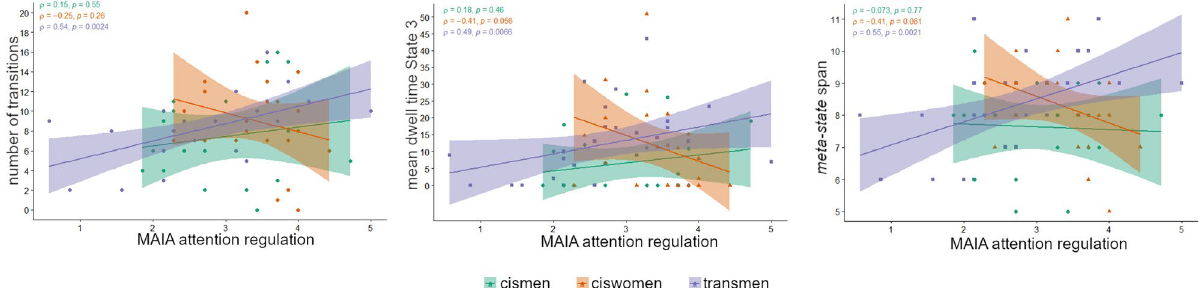
Figure 5. Correlations of the attention regulation Multidimensional Assessment Interoceptive Awareness (MAIA) dimension with metrics of the 4-states cluster solution. Within the transmen group, the number of transitions and the dwell time in State 3 as metrics of the sliding windows k-means clustering approach, were positively associated with the attention regulation dimension; there was also a positive correlation between this MAIA dimension and the meta-state span. Correlations are rho Spearman, and shadowed areas represent the 95% confidence interval. Plots were obtained with the ggpubr library (https:// cran.r- proje ct. org/ web/ packa ges/ ggpubr/ index. html) using the RStudio v1.4.1106 (PBC, Boston, MA, http:// www. rstud io.